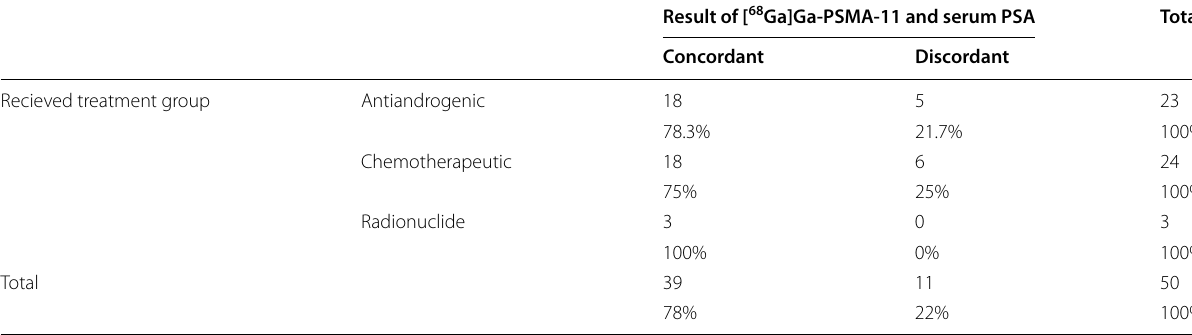
Table 5 The distribution of received therapies in terms of effect mechanism in concordant and discordant